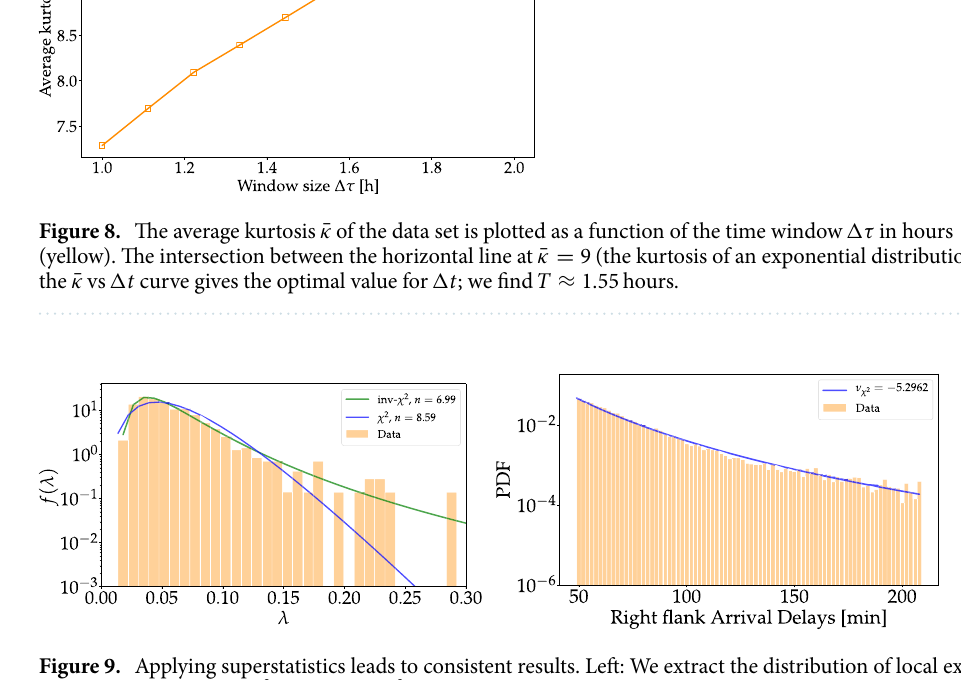
Figure 9. Applying superstatistics leads to consistent results. Left: We extract the distribution of local exponents 2 2 and compare them to a χ and inverse χ fit (based on the method of least squares). Right: Using the previously 2 derived χ distribution, we again derive a q -exponential with right exponent ν χ 2 ≈ − 5.296 , compared to